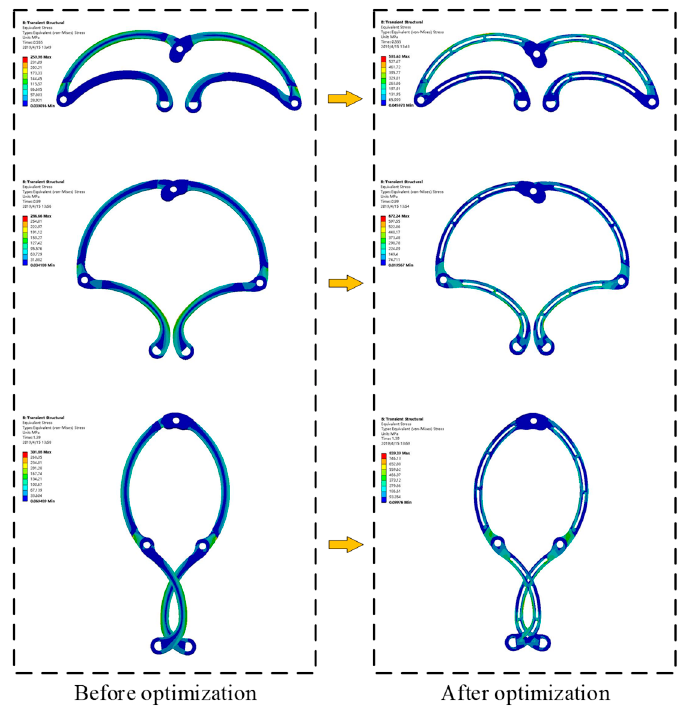
Figure 17. Comparison of stress distribution before and after optimization.